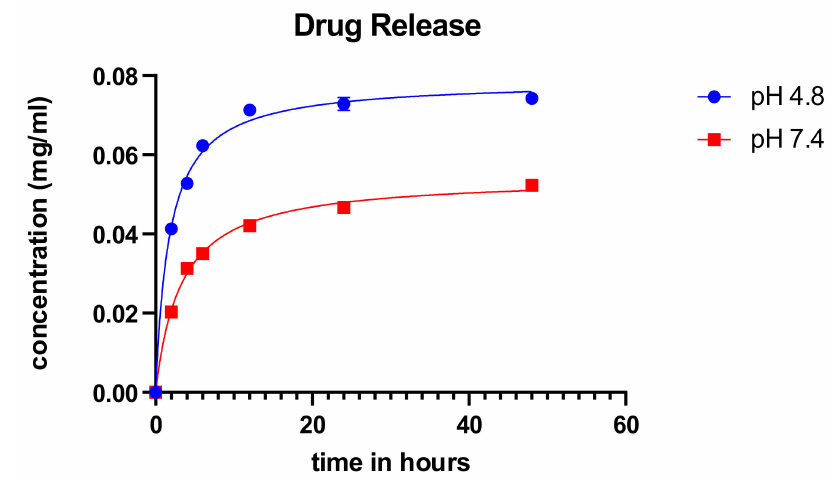
Figure 6. Cumulative drug release of carboplatin from SFCP microparticles. X-axis corresponds to time (in